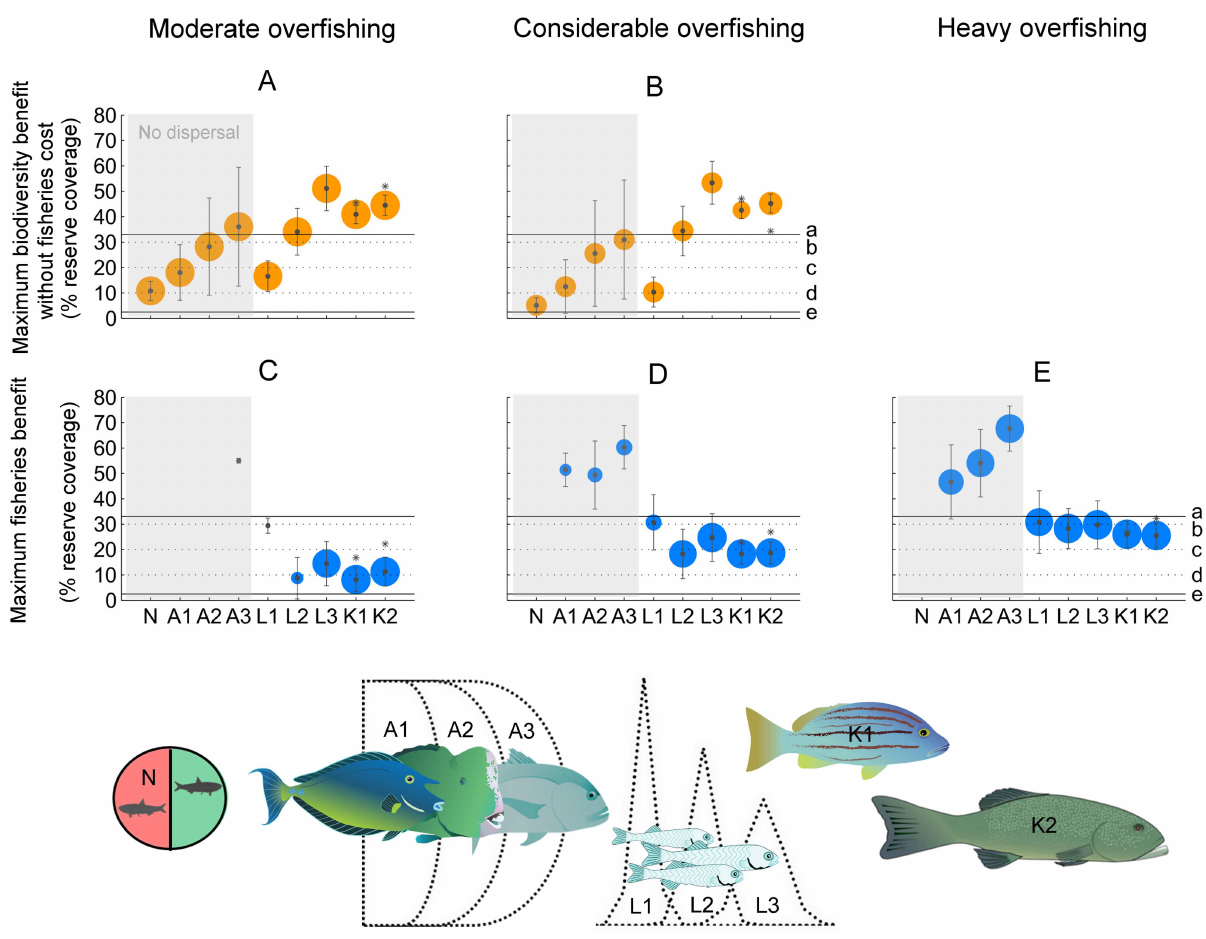
Fig 1. Marine reservecoverage targets for unregulated fisheries under increasing levels of overexploitation. (A–B) The maximum reserve coveragefor biodiversity conservation that does not depleteinitiallygood fisheriescatch. (C–E) The optimum reserve coverageto rebuildfisheries catch. Circles and errors bars represent means ± SD, scalingin size to the number of fishery scenariosthey represent. Small circles, no circles, or no plot mean that the catch was either not initiallyhigh (A–B) or not improvedthrough reserves (C–E). Outcomes are categorized based on increasing levels of exchangethrough adult movements (A1–A3) and larval dispersal(L1–L3)across reserve boundaries.Exchangecategories are: (N) no exchange,(1) 10%–20%, (2) 30%–50%, and (3) 60%–100%.Assuming realistic reserve sizes of 1–20 km, the home ranges of most adult coral reef fishes [17] suggest classifications under exchangecategory A1 or lower ( < 10%). Dispersaldistances of coral reef fish larvae [18,29]suggest classifications under exchangecategoriesL2–L3. Keppelisland (K) scenarios represent spatiallyexplicit calculations of exchangefor Lutjanuscarponotatus (K1) and Plectropomusmaculatus (K2) assumingreserve sizes of 4 ± 4 km (mean ± SD). Results for 2 ± 2 km reserves are indicatedby star symbols. The reference lines mark enforced (solid) and anticipated (dotted) reserve coverages: (a) Great Barrier Reef; (b) InternationalUnionfor Conservationof Nature (IUCN) recommendation; (c) Coral TriangleInitiative (CTI) long-term goal; (d) Aichi and CTI 2020 target; and (e) Coral Triangle. The full range of fishery scenarios includedall combinations of fish movements (see all results in S2 Table). See Materials and Methods for details. Images: CatherineCollier (ian-symbol-plectropomus-spp.svg), ChristineThurber (ian-symbol-naso-unicornis.svg), Jane Thomas